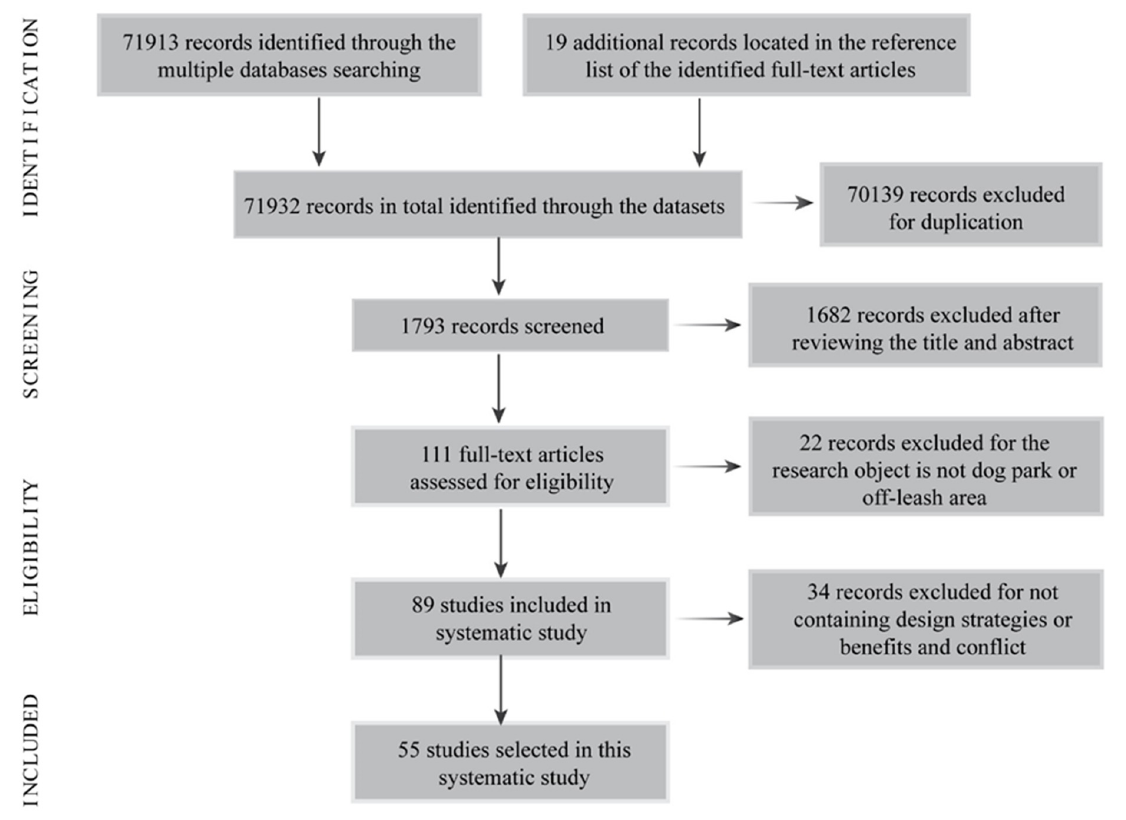
Animals 2022 , 12 , x FOR PEER REVIEW 17 of 28